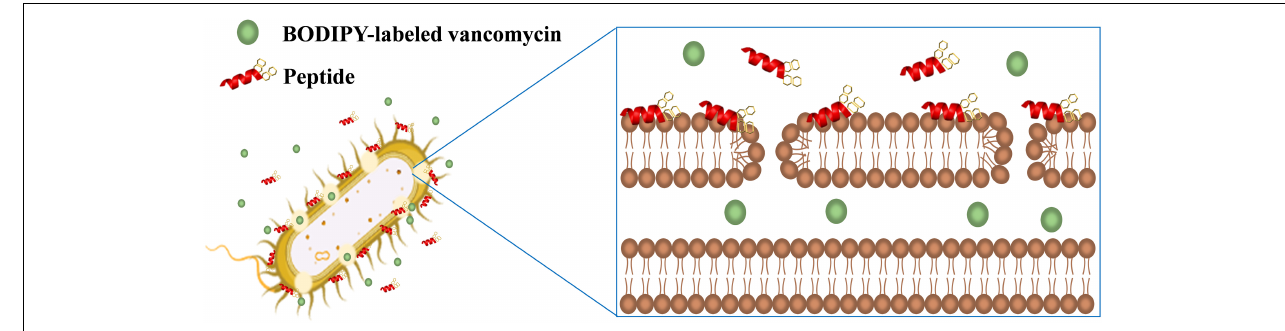
FIGURE 6 | Schematic illustration of the synergistic mechanism for BODIPY-labeled vancomycin and peptides. S1-Nal-Nal (red) disturbs the bacterial outer membrane and enhances the entry of BODIPY-labeled vancomycin (green circle) into bacteria.